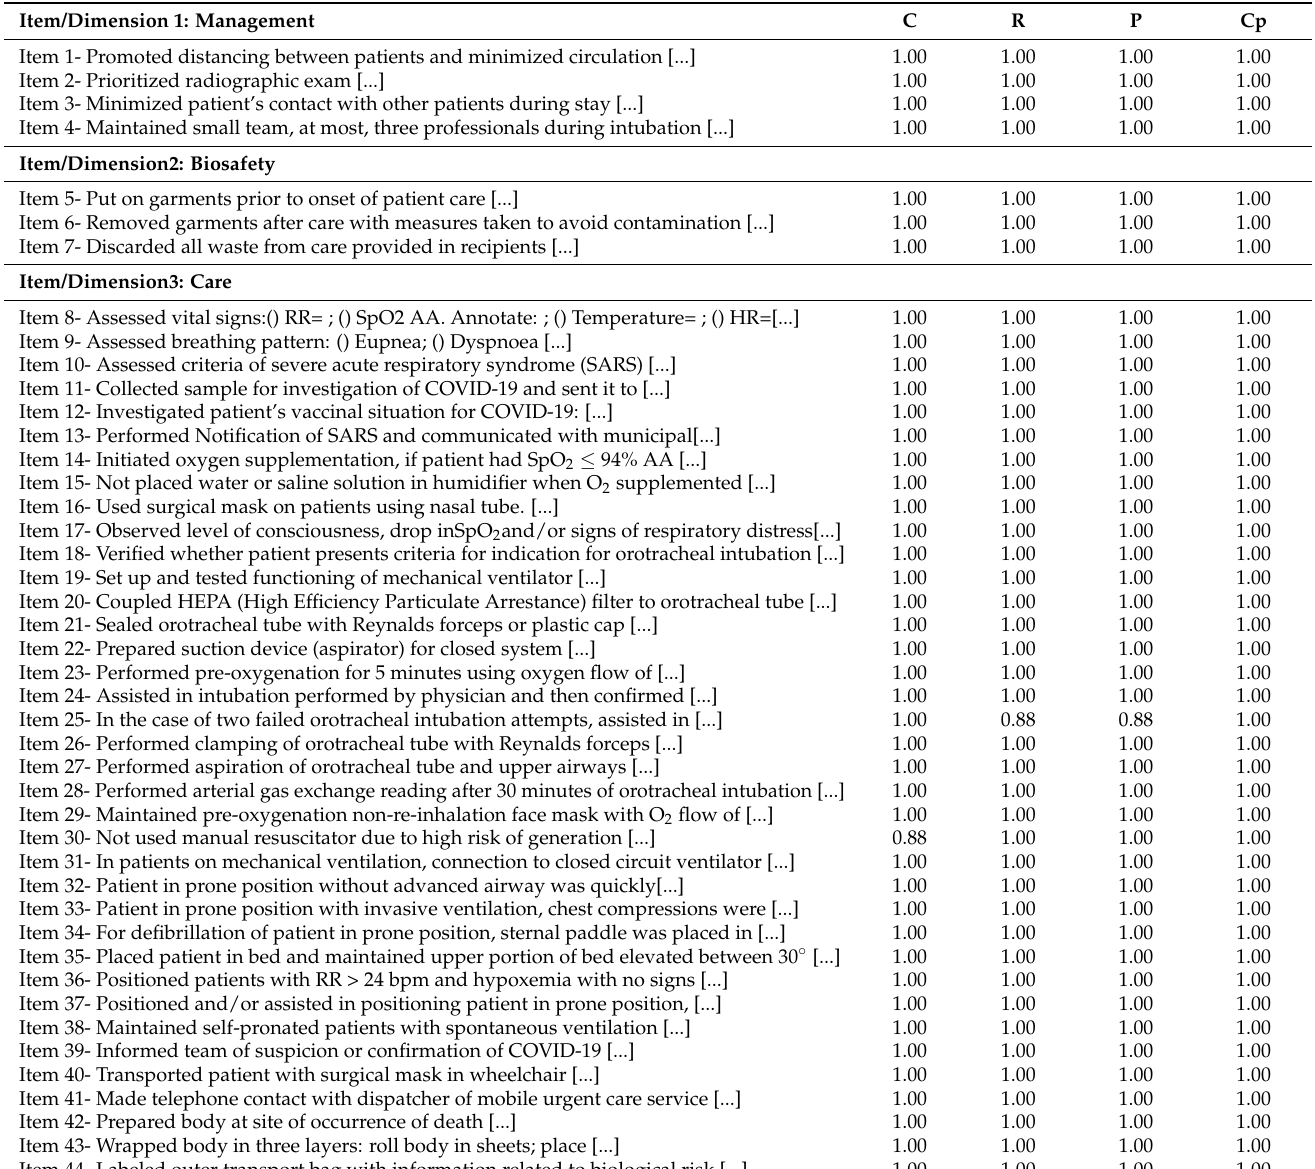
Table 3. Content validity indices of items in relation to criteria analysed and dimensions proposed by judges. Bauru, S ã o Paulo,